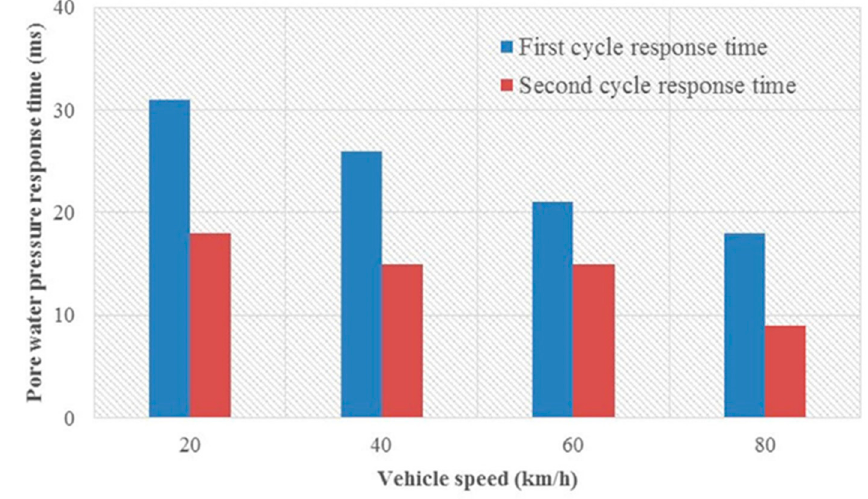
Figure 8. The time of two cycles at different speed.